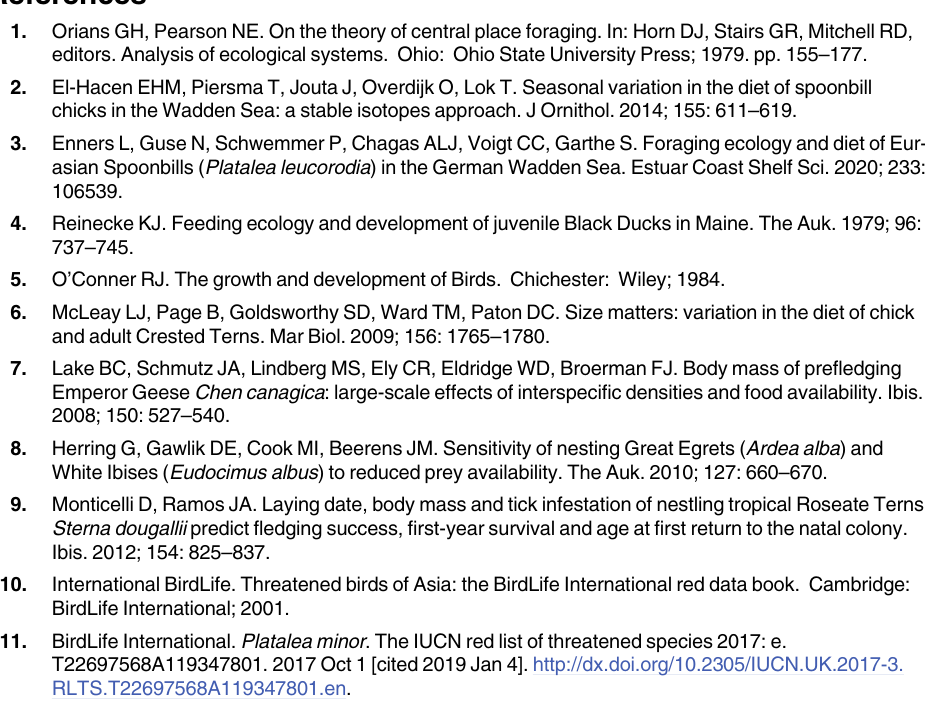
S3 Table. δ 13 C and δ 15 N values from primary feathers of Black-faced Spoonbill chicks.